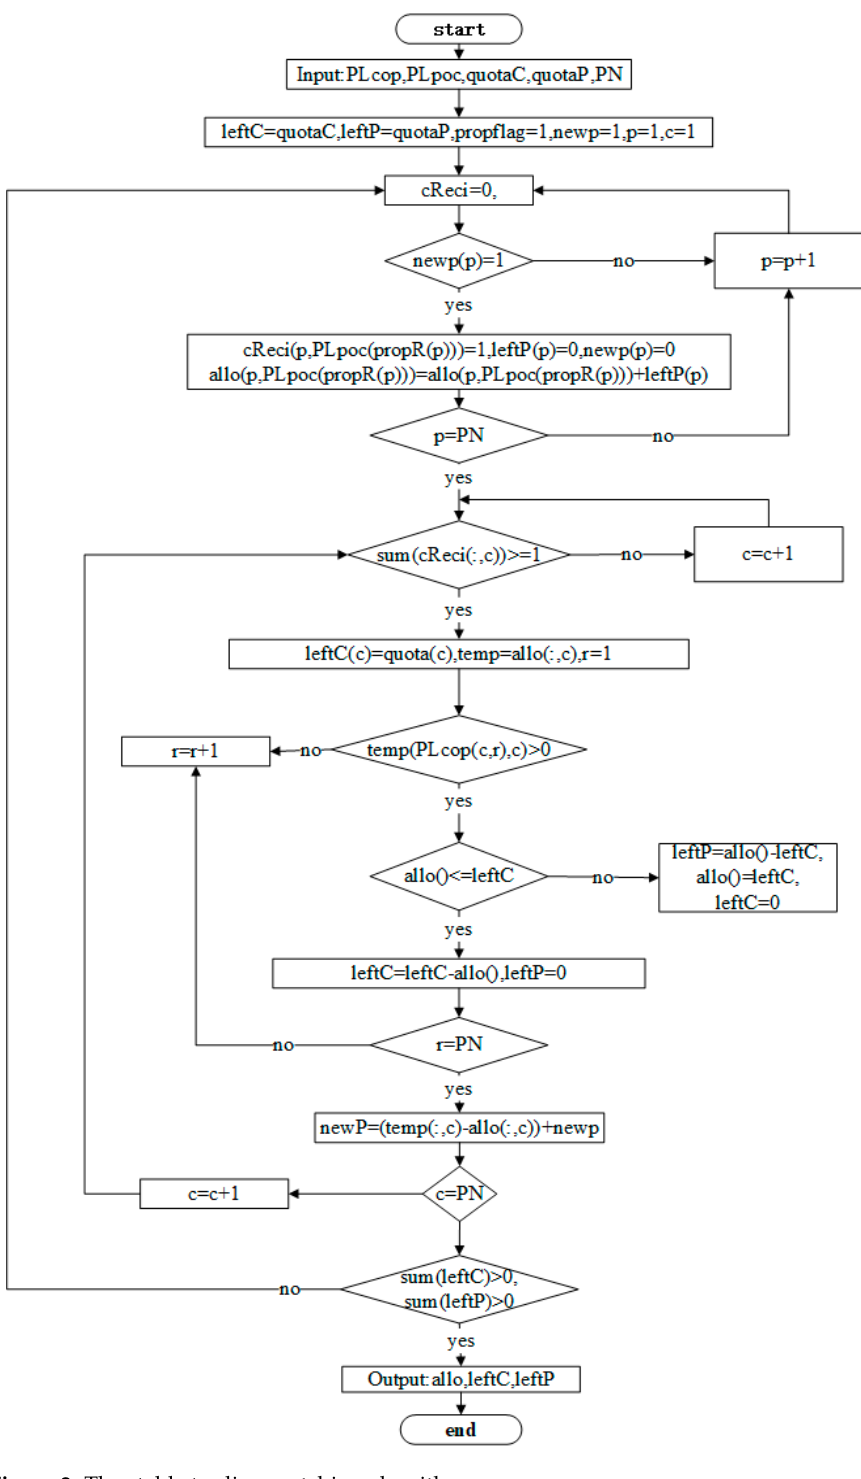
Figure 2. The stable trading matching algorithm.